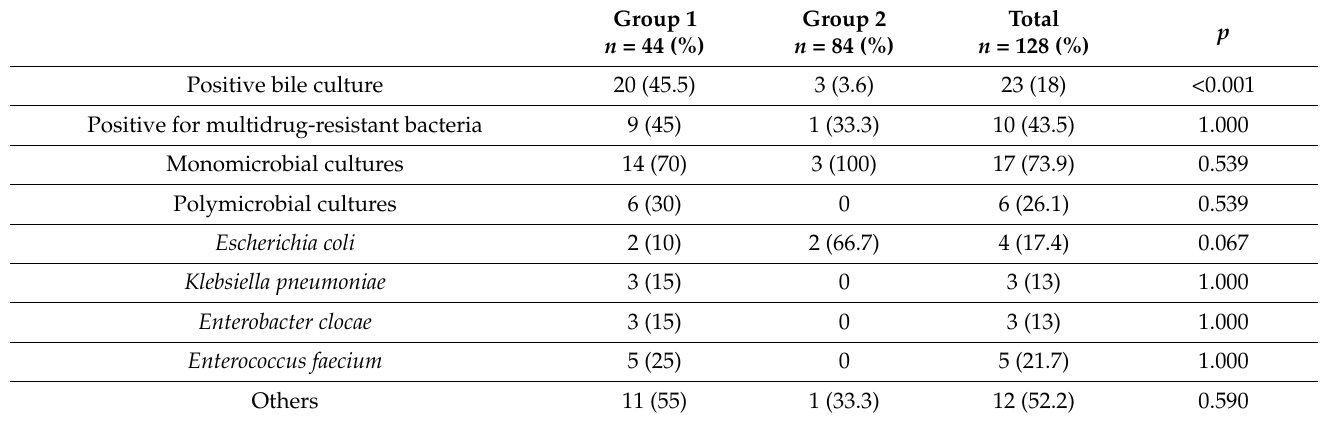
Table 1. Detailed intraoperative bile cultures.